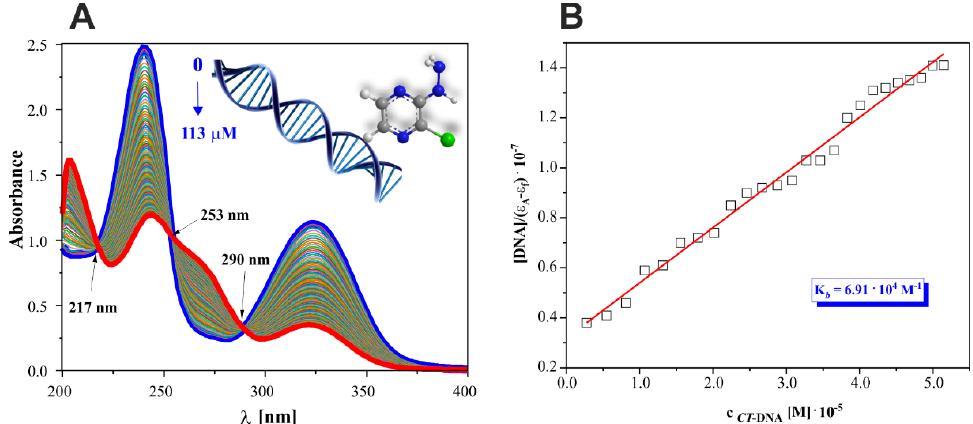
Figure 8. Absorption titration of 2Cl3HP derivative ( A ) with increasing concentrations of CT − DNA (0 − 113 μ M). Arrows show isosbestic points obtained upon increasing CT − DNA concentration; ( B ) the plot of [DNA]/( ε A − ε f ) vs. [DNA]; □ , experimental data points at 239 nm for 25 portions of DNA added; solid line, linear fitting of the data (R 2 = 0.98785).